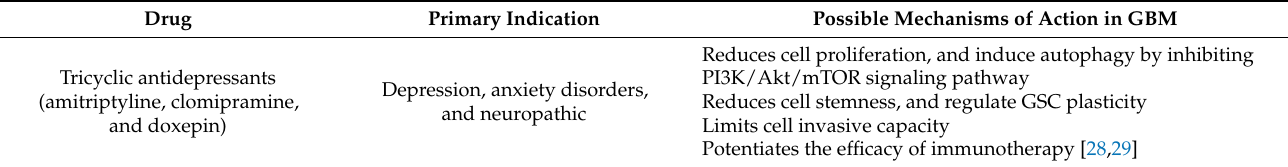
Table 2. Drugs in preclinical investigation. Acronyms used: AKT: v-akt murine thymoma viral oncogene homolog; AMPK: adenosine monophosphate-activated protein kinase; Bcl-2: B-cell lymphoma-2; Beclin-1: Beclin-1 protein; CD74: cluster of differentiation 74; DCA: dichloroacetate; elF4E: eukaryotic initiation factor 4E; ERK: extracellular regulated protein kinases; EZH2:zeste homolog 2; FAK: focal adhesion kinase; FDA: food and drug administration; GBM: glioblastoma; GSC: glioma stem cells; IKBKE: inhibitor of nuclear factor kappa B kinase subunit epsilon; MAPK: mitogen-activated protein kinase; MIF: migration inhibitory factor; miR-21: microRNA 21; MTOR: mechanistic target of rapamycin; PI3K: Phosphatidylinositol-3-kinase; PD-L1: programmed death-ligand 1; ROS: reactive oxygen species; STAT3:signal transducer and activator of transcription 3; and TMZ: